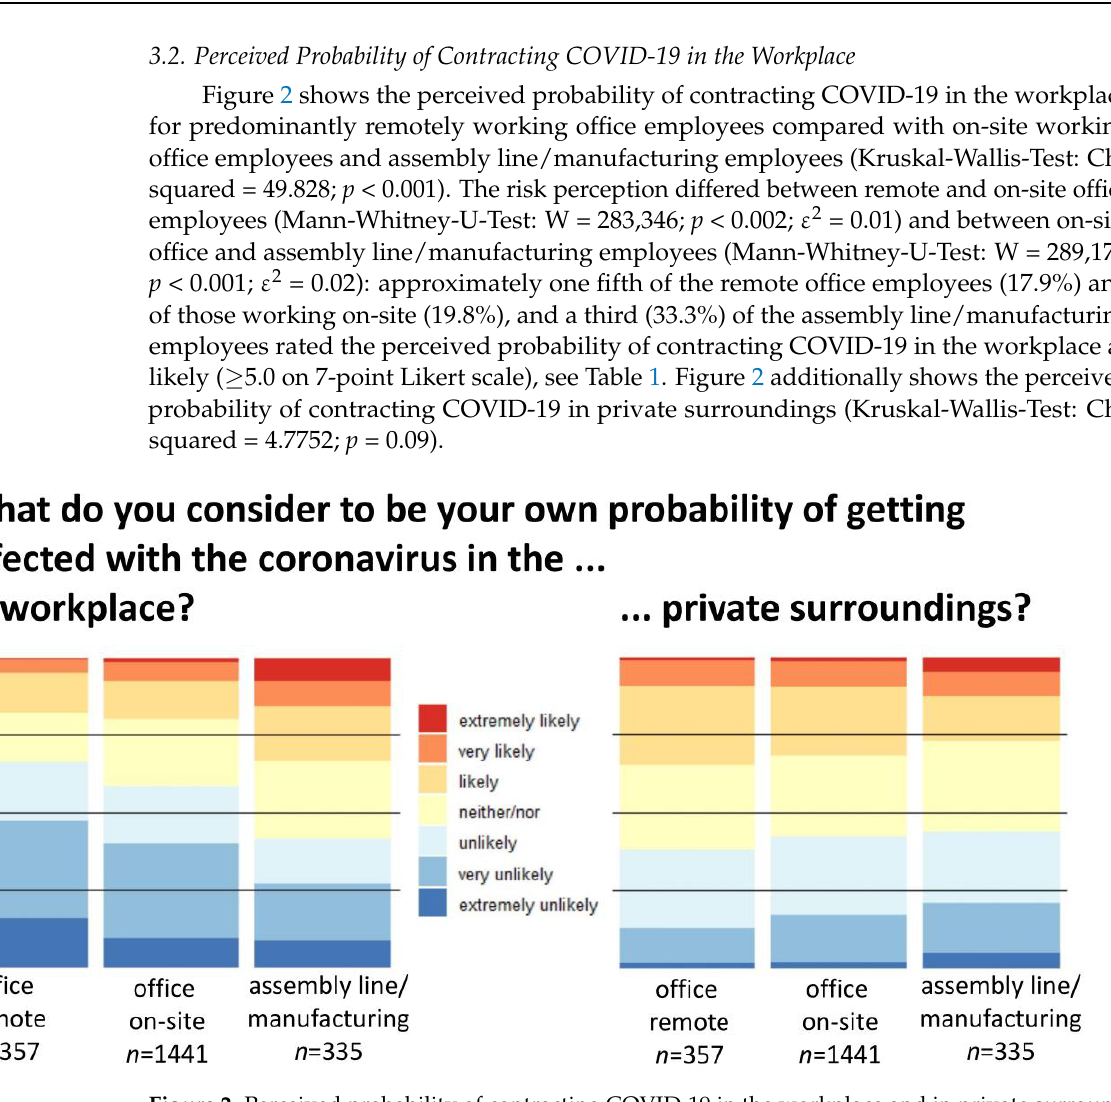
Figure 2. Perceived probability of contracting COVID-19 in the workplace and in private surround- ings, compared by occupational group: office predominantly remote ( n = 357), office on-site ( n = 1441), and assembly line/manufacturing ( n = 335).